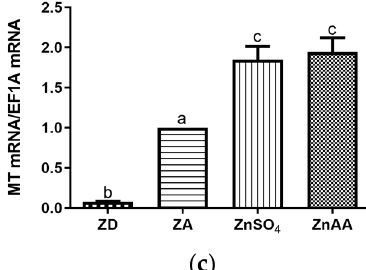
Figure 1. ( a ) A total of 1 × 10 6 SF cells per ml were loaded with FluoZin3-AM, base line fluorescence was recorded for 10 min and increase in fluorescence after adding ZnSO 4 (50 µM) or ZnAA (50 µM) was monitored for additional 60 min. ( b , c ) SF cells were cultured in CHELEX-treated medium, zinc adequate (ZA) medium or medium supplemented with ZnSO 4 (50 µM) or ZnAA (50 µM) for 7 days. Afterwards total zinc of the cells was analyzed using AAS or mRNA was isolated and used for measuring MT mRNA expression normalized to EF1A. Mean values + S.E.M. of at least n = 7 inde- pendent experiments are shown. Significant differences between ( a ) ZnSO 4 and ZnAA (multiple t tests, * p < 0.05) are marked. In ( b , c ), significantly different data sets as determined by one-way Anova and Tukey’s post hoc test do not share the same letters ( p < 0.05).